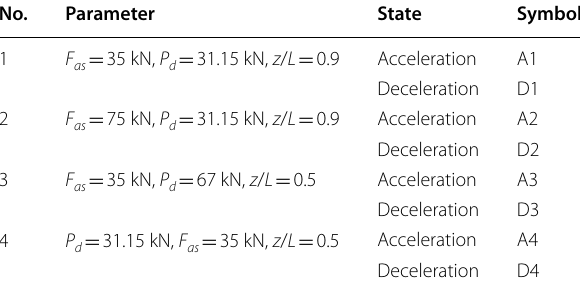
Table 3 Symbols for the eight combinations of